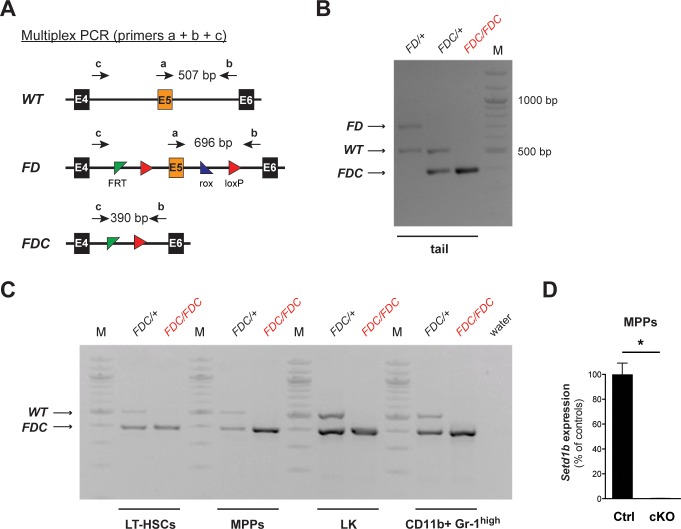
Complete recombination is achieved in FACS-sorted hematopoietic cell populations after tamoxifen induction.(A) Multiplex PCR strategy allowing for the parallel detection of the FD, WT, and recombined FDC allele of Setd1b. Corresponding primer binding positions and expected amplicon sizes for the PCR are schematically illustrated. (B) Representative genotyping results using genomic tail DNA. In homozygous Setd1bFDC/FDC;RC/+ mice, only the recombined product (FDC) at a size of 390 bp is detectable. (C) Genotyping results in FACS-sorted LT-HSCs, MPPs, LK cells, and CD11b+ Gr-1high granulocytes from BM. Complete recombination was achieved in all analyzed cell populations from Setd1bFDC/+;RC/+ controls (n = 2) and Setd1bFDC/FDC;RC/+ cKO mice (n = 2) 7 weeks after tamoxifen induction. (D) qRT-PCR analysis of Setd1b expression in MPPs 12 weeks after induction. Setd1b mRNA was completely lost in cKO cells (n = 2) compared to controls (n = 2) and relative to Rpl19 expression. The mean ± SD is illustrated (p*=0.041). (M = molecular marker, E = exon, bp = base pairs).